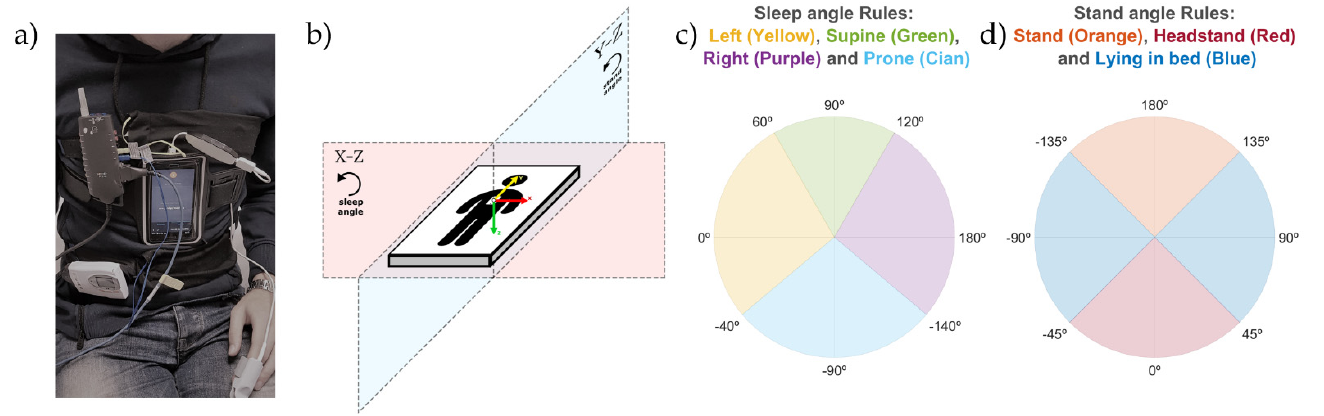
Figure 1. Picture of the smartphone and PSG device placement ( a ) and representation of the smartphone placement ( b ) including the direction of the accelerometry X axis (red), Y axis (yellow) and Z axis (green) as well as the X-Z plane, where the sleep angle is calculated, and the Y-Z plane, where the stand angle is calculated. Explanation of the rules used to discretize the sleep angle ( c ) and stand angle ( d ). The sleep angle was classified into the four sleep positions: supine, prone, left and right. The stand angle into two categories: standing (either stand or headstand) and lying. The stand category also had a second constraint (3).